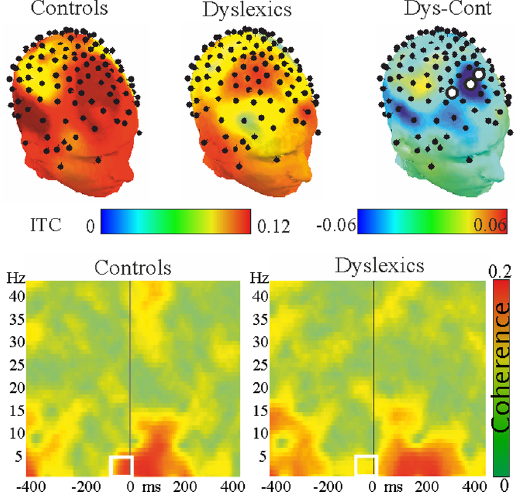
Figure 2. Time-frequency plots, 2 hz condition. The two lower panels show ITC across frequencies from 0 to 40 Hz for dyslexics (right panel) and controls (left panel). Dashed vertical lines indicate the time of stimulus arrival. Statistical analysis revealed significant group differences in the delta frequency range ( , 0.5–4 Hz) in the prestimulus interval ( 2 40–0 ms). Topographic headplots show ITC values over the whole head for both groups and the difference between the groups. Electrodes with significant group difference are marked with